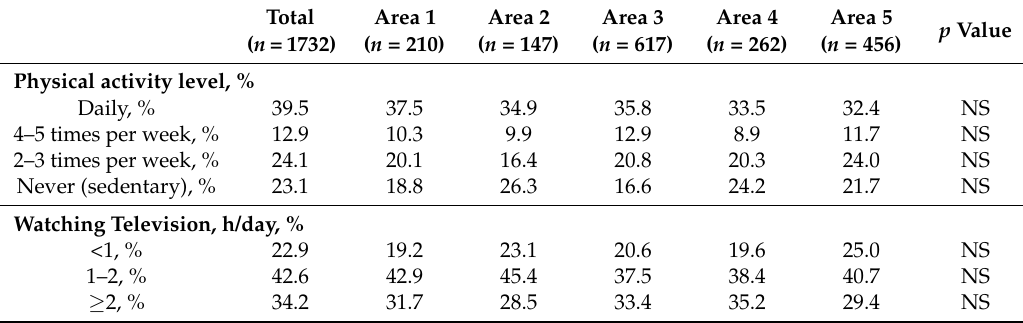
Table 2. Lifestyle habits in the total population ( n = 1732).